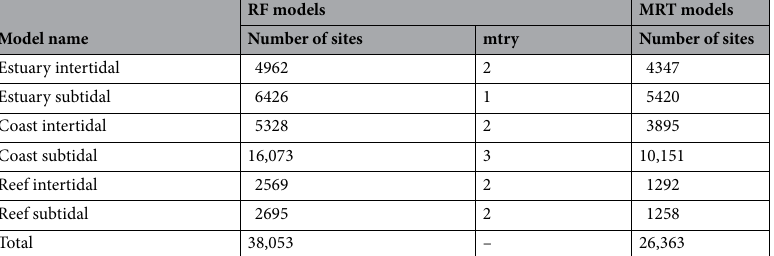
Table 5. Random Forest (RF) and Multivariate Regression Tree (MRT) model specifications for estuarine, coastal and reef intertidal and subtidal areas in the Great Barrier Reef World Heritage Area and adjacent estuaries. Total number of sites used in each model (split between 80% for model training and 20% for testing), total sites used in each model, and the optimal number of predictor variables that were randomly selected at each node in RF models